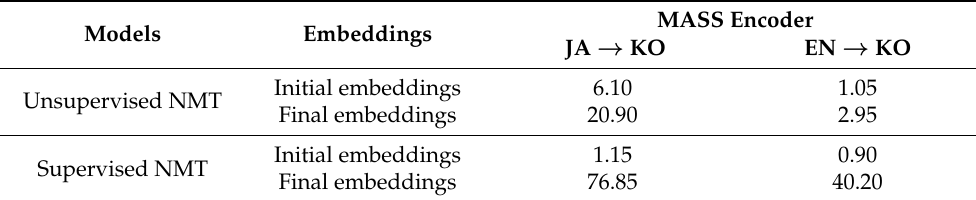
Table 5. The performances of sentence-translation